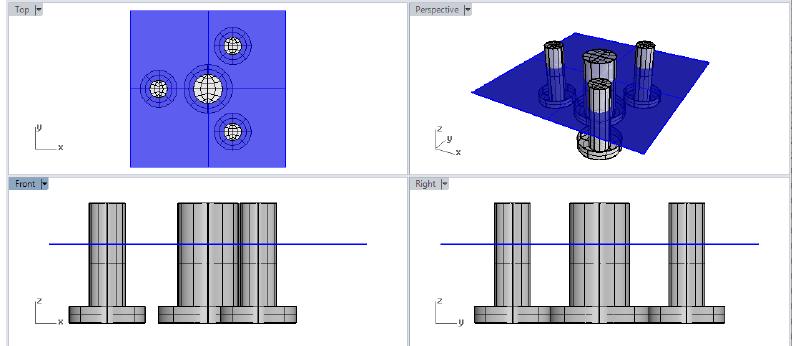
Figure 10. High-order mesh of columns and heave plates—Even keel.